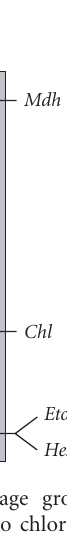
[14] and a Belgian resistant population (2,939 mg L − 1 )